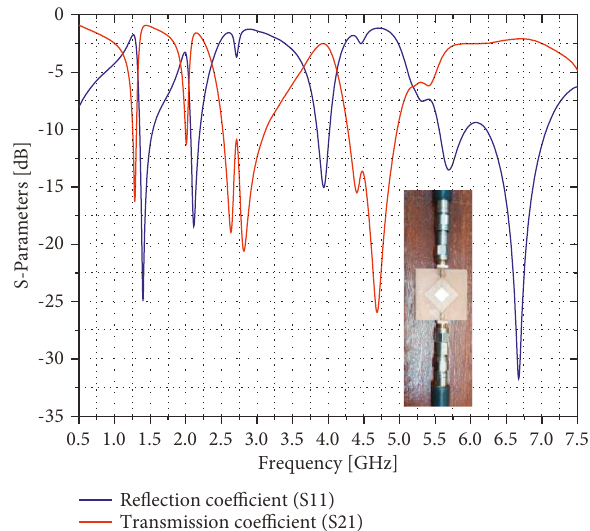
Figure 10: Measured reflection and transmission coefficient of the proposed quadband